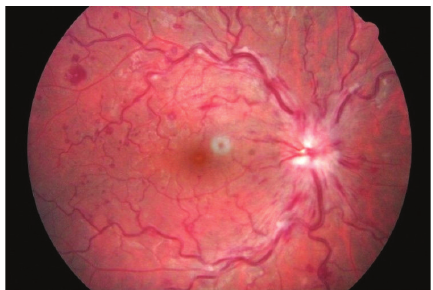
Figure 1: Scattered hemorrhages, increased venous tortuosity, and papilledema in the right eye.